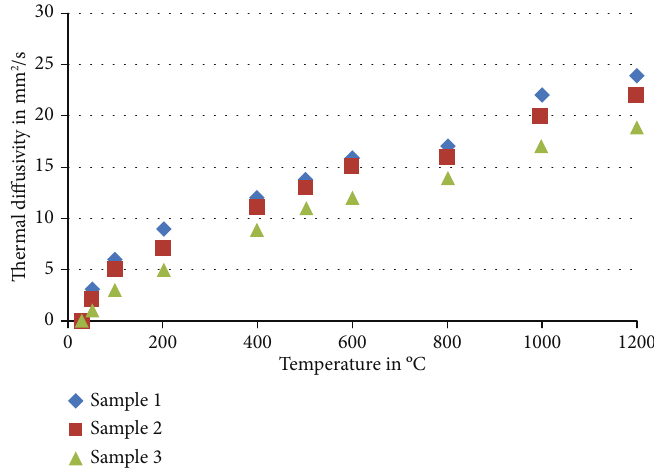
Figure 4: Thermal di ff usivity of silver matrix hybrid